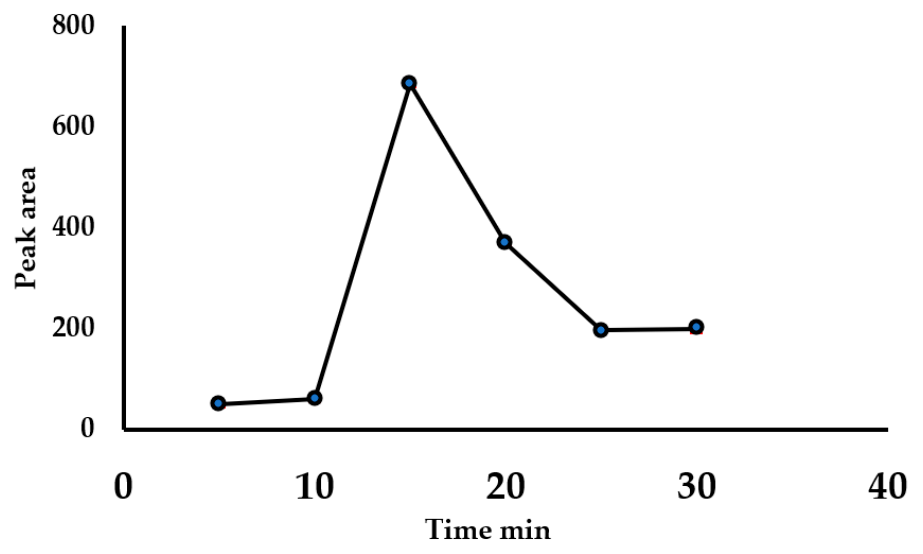
Figure 4. Effect of sonication time during extraction.